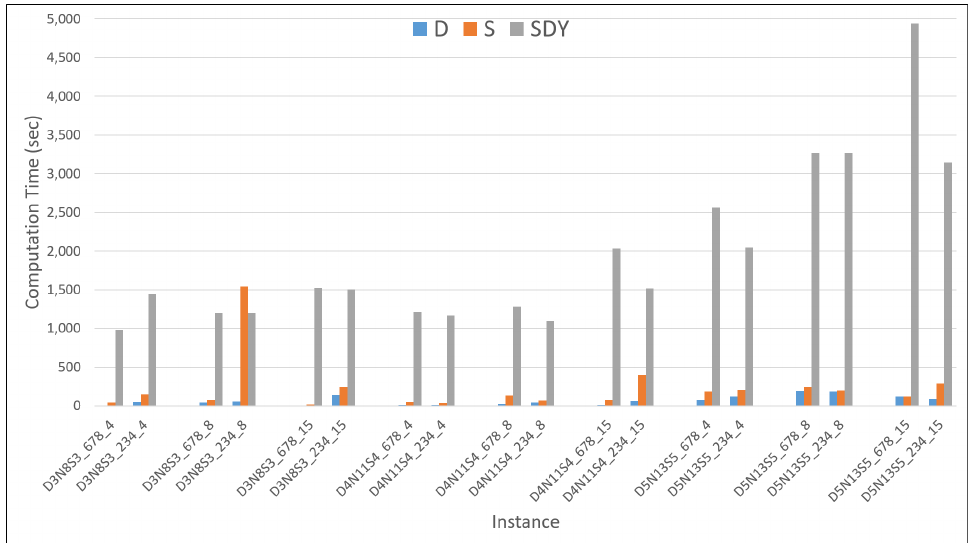
Figure A13. Computation Time: Offline and Online computation based on Model Characteristic and Maximum Road Capacity Setting.